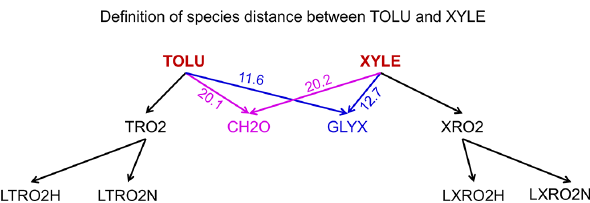
Figure 1. Definition of species distances for TOLU (toluene) and XYLE (xylene) using the analysis of family trees in graph theory. The number denotes the distance between species as calculated by Eq. (3). The shortest path from TOLU to XYLE is TOLU–GLYX– XYLE in this graph, where GLYX is